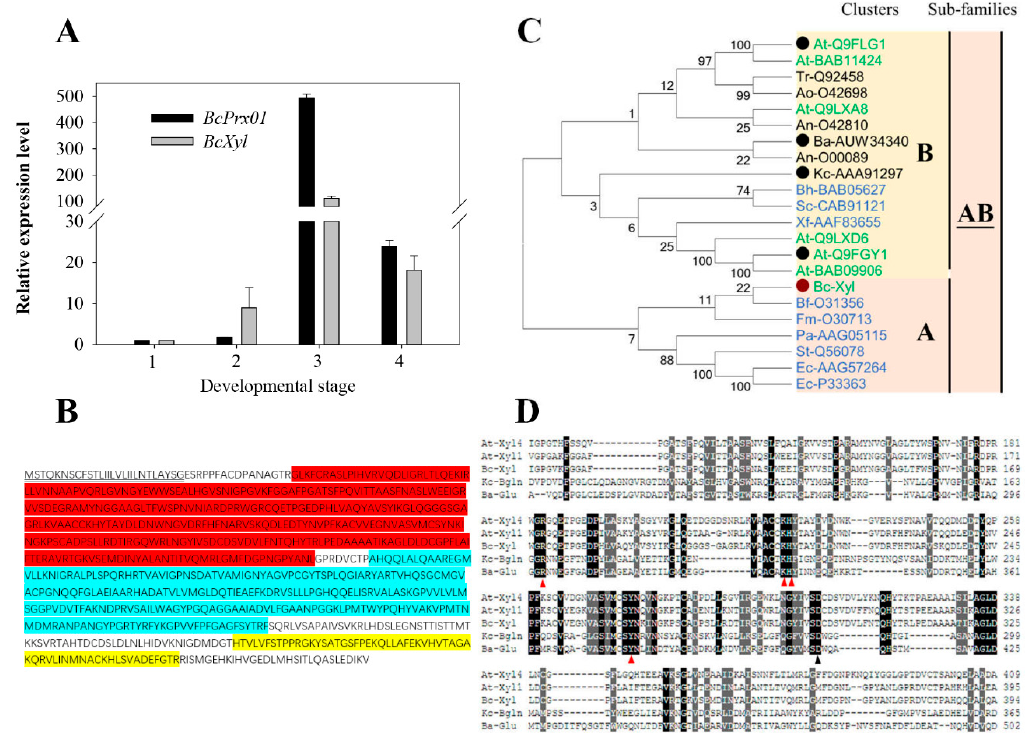
Figure 6. Gene expression and full-length amino acid sequence analysis of a BcXyl. ( A ) Relative expression levels of BcXyl and BcPrx01 during the flower development of B. Calycina . The relative levels of the genes were acquired by qPCR with B. calycina 18s rRNA (L49274) as internal reference. ( B ) Domains in the deduced amino acid sequence of BcXyl . Putative domains include: a secretion protein (SP) signal peptide (doubly underlined); N-terminal domain of Glycoside hydrolase family 3 (GH3) (red); C-terminal domain of GH3 (light blue); fibronectin type III domain of GH3 (yellow). ( C ) A rooted neighbor-joining phylogenetic tree of the amino acid sequences of subfamily AB from GH3. The sequences from bacteria, fungi and plants, indicated by blue, black and green respectively. Two clusters (A and B) are based on clusters classification of GH3 by Cournoyer and Faure (2003) [21]. The red dot indicates BcXyl and the black dots high light sequences included in the alignment in (D). ( D ) Amino acid sequence alignment analysis of BcXyl with four members from cluster AB of GH3. Multiple sequence alignment using COBALT including AtXyl1 (Q9FGY1) and AtXyl4 (Q9FLG1) from Arabidopsis thaliana ; Bgln from Kuraishia capsulata (AAA91297) and BadGluc from Bjerkandera adusta (AUW34340). Conserved areas are shadowed in grey/black, the catalytic nucleophile Asp is marked with a black triangle and red triangles represent the predicted amino acid residues, which might be involved in substrate